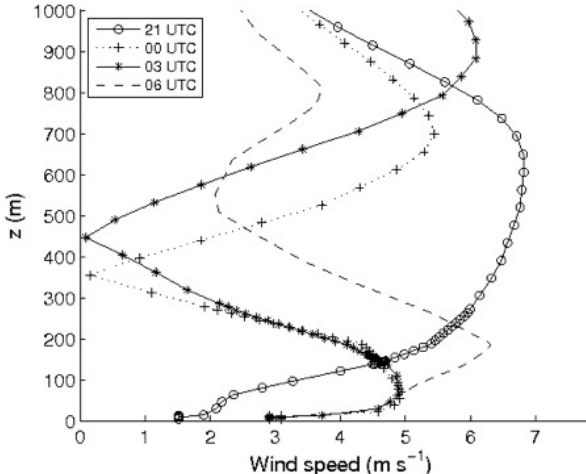
Figure 3. Simulated vertical wind profile at di ff erent hours during the night of 13th and early morning of 14th at the point marked by a black dot in Fig. 1.